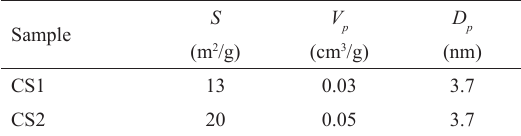
Table 1: Structural parameters obtained from nitrogen porosimetry measurements; S is the SSA, V D is the average pore p